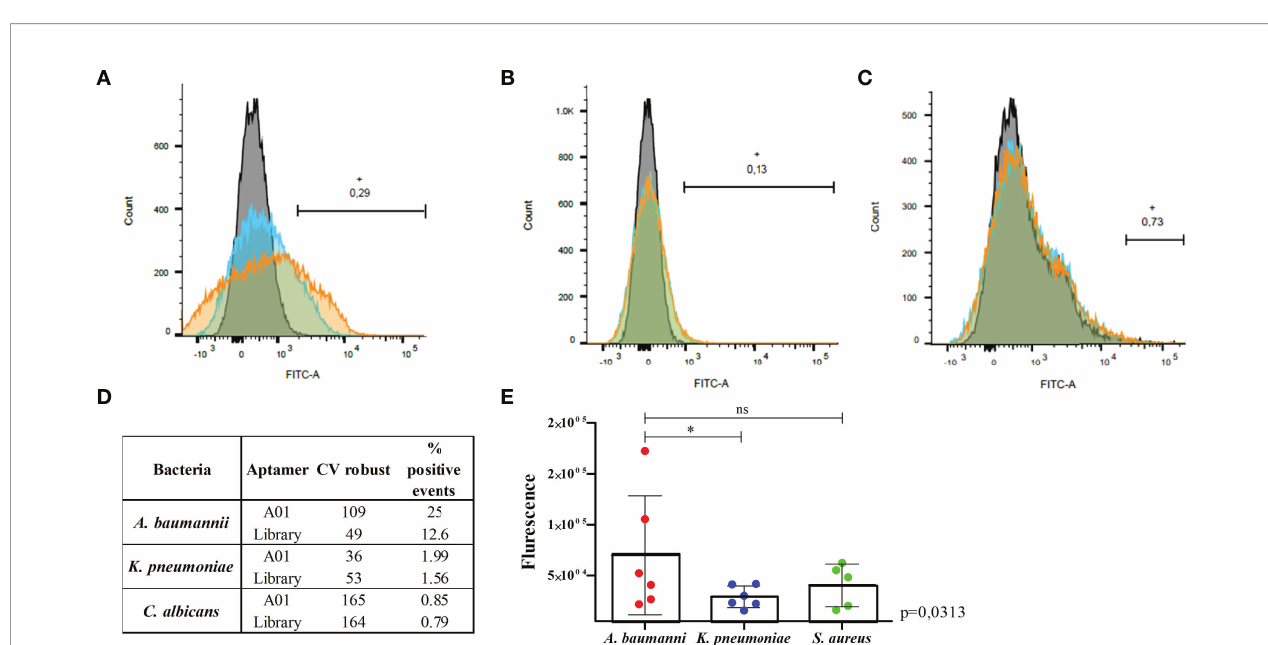
FIGURE 4 | Fluorescence assays for A01 aptamer with A. baumannii compared to K. pneumoniae , C. albicans or S. aureus cells. Binding of the A01 aptamer (orange) relative to the starting library (blue) to A. baumannii (A) , K. pneumoniae (B) and C. albicans (C) . The fl uorescence of cells without aptamer are indicated in grey. The black line indicates the number of positive events beyond the control (cells without aptamer) of the aptamer A01. CV robust and % of positive events are shown in the table (D) . Fluorimeter assay (E) for the aptamer A01 incubated with A. baumannii (red), K. pneumoniae (blue) or S. aureus (green). The average of each of the 6 experiments is shown in the graphics. * signi fi cant p value; ns, non sigi fi cant p value. Wilcoxon test was applied with p value = 0.031 when A. baumannii was compared to K. pneumoniae and 0.537 when compared to S. aureus